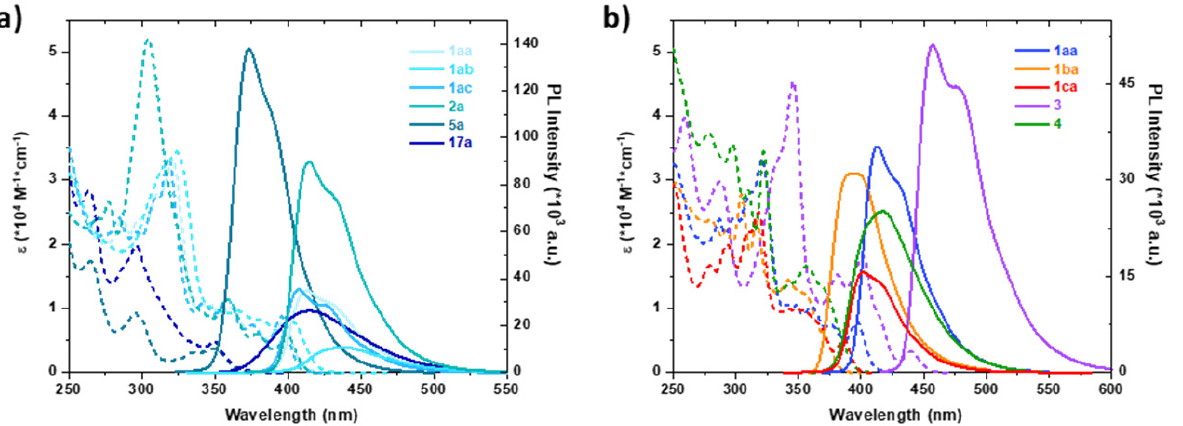
Figure 5. ( a ) Absorption (dashed) and emission (solid) spectra in CH 2 Cl 2 of carbazole-based thiahelicenes and the intermediates 5a and 17a . ( b ) Absorption (dashed) and emission (solid) spectra in CH 2 Cl 2 of the thiahelicenes bearing two pending phenyl groups and prepared within this work. Emission spectra were normalized to 0.1 intensity at excitation wavelength.